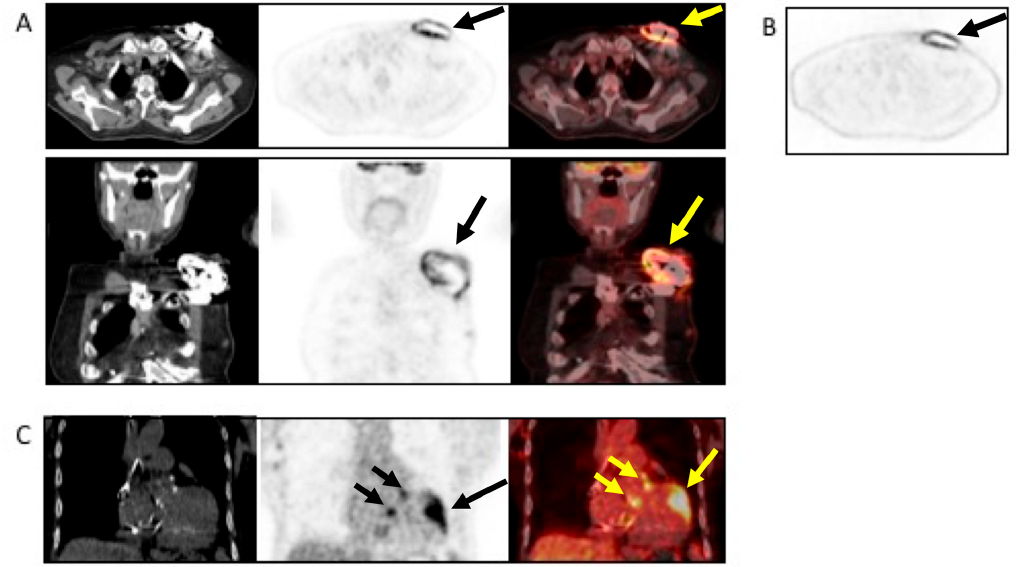
Figure 8. Example of the use of ( 18 F)FDG PET/CT in a patient with non-Hodgkin's lymphoma and sudden onset of fever and a positive blood culture for Streptococcus dysgalactiae. The patient underwent TTE and TEE, which were negative. Antimicrobial treatment was started. Due to the lack of clinical response, the patient underwent ( 18 F)FDG PET/CT, which revealed infection, as indicated by the black and yellow arrows, involving the pocket of the device (A, from left to right, CT, PET, and superimposed PET/CT transaxial (upper panel) and coronal (lower panel and B non-attenuated corrected transaxial images) as well as the intracardiac portion of the lead extending to the tricuspid valve (C, from left to right, noncontrast CT, PET, and fused PET/CT coronal images). Based to the PET/CT findings, the device was extracted and replaced.